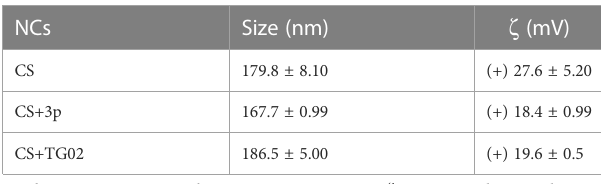
TABLE 1 Physical-chemical characterization of nanocapsules of CS in the absence and presence of mutated antigenic